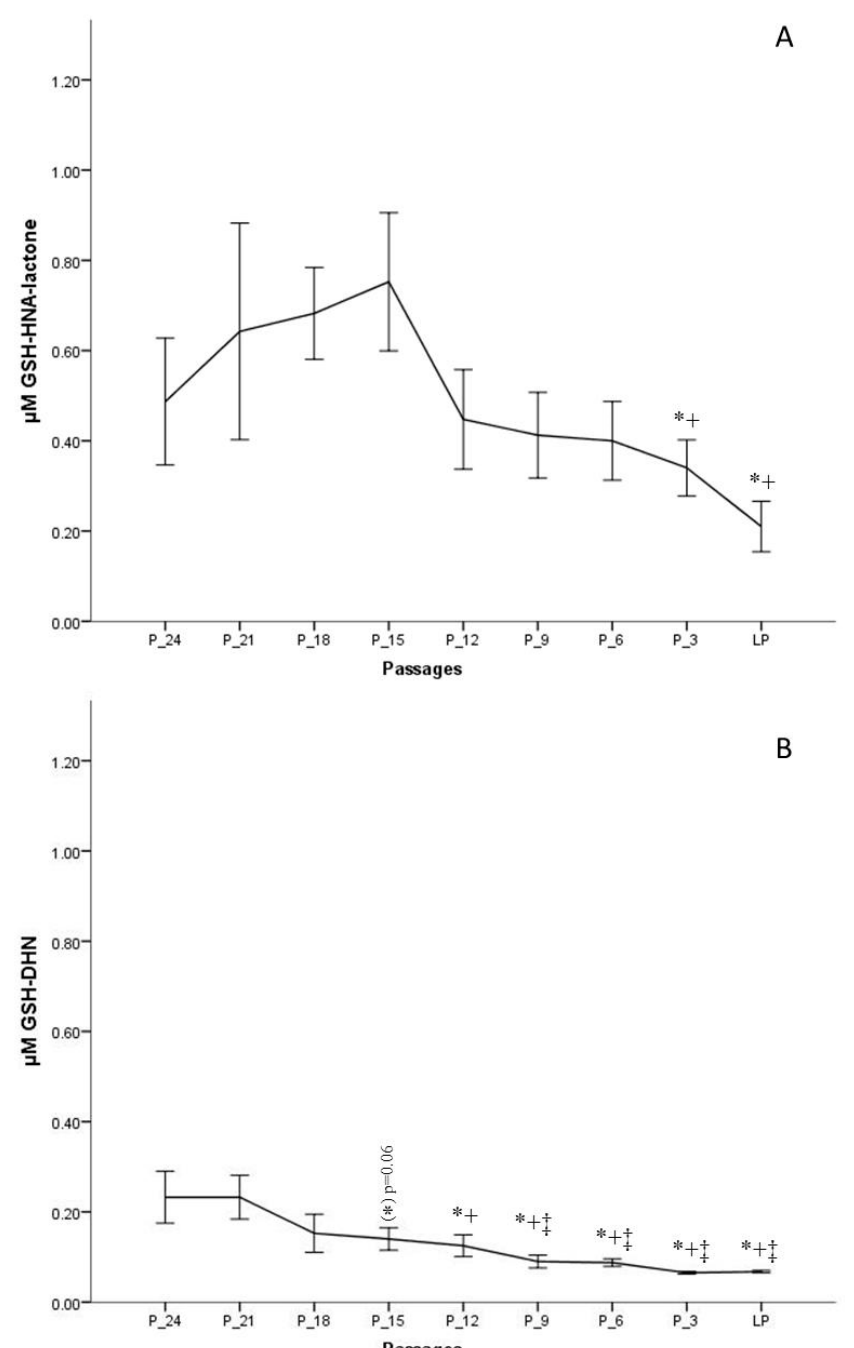
Figure 5. Concentrations of GSH-HNA-lactone ( A ) and GSH and 1,4-dihydroxynonene (GSH-DHN) ( B ) conjugates measured after 30 min of incubation with 5 µ M HNE at di ff erent passages of fibroblast culture. Data are presented as means ± SD ( n = 4). ( A ) Statistically significant di ff erences are marked with * as compared with P-18 and with + as compared with P-15. ( B ) Statistically significant di ff erences are marked with ‡ as compared with P-24, * as compared with P-21, and with + as compared with P-15; for p < 0.05, as analyzed by Student’s two-tailed t-test for independent